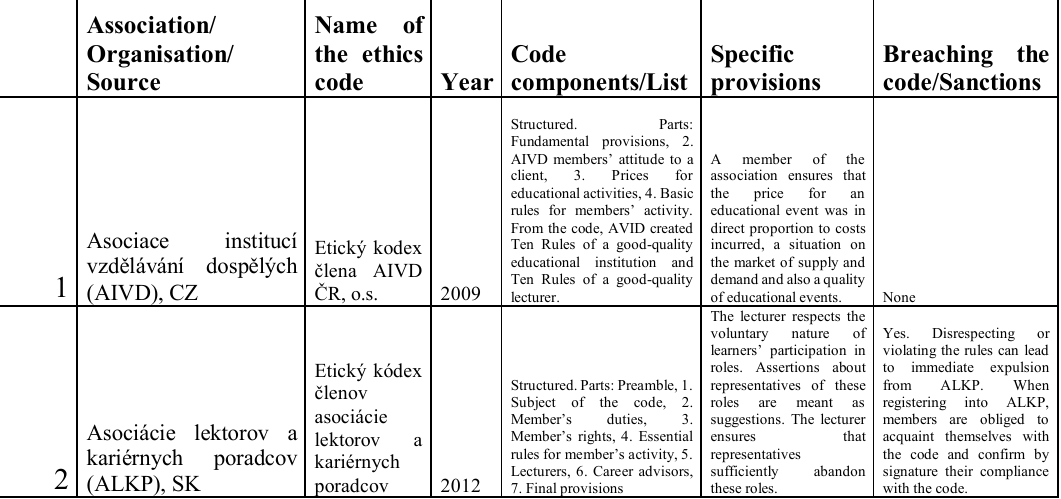
Table 2: Results of the analysis of codes according to selected criteria